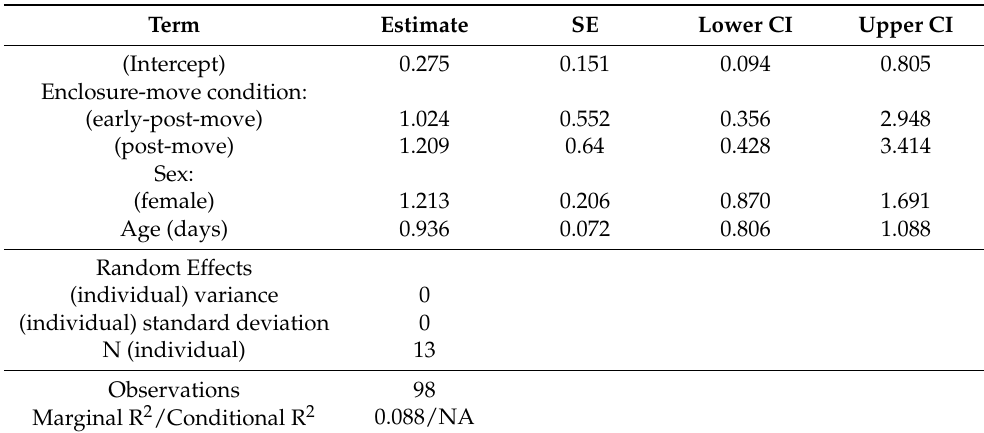
Table A11. Model 6 summary output: Effect of enclosure move on crested macaque